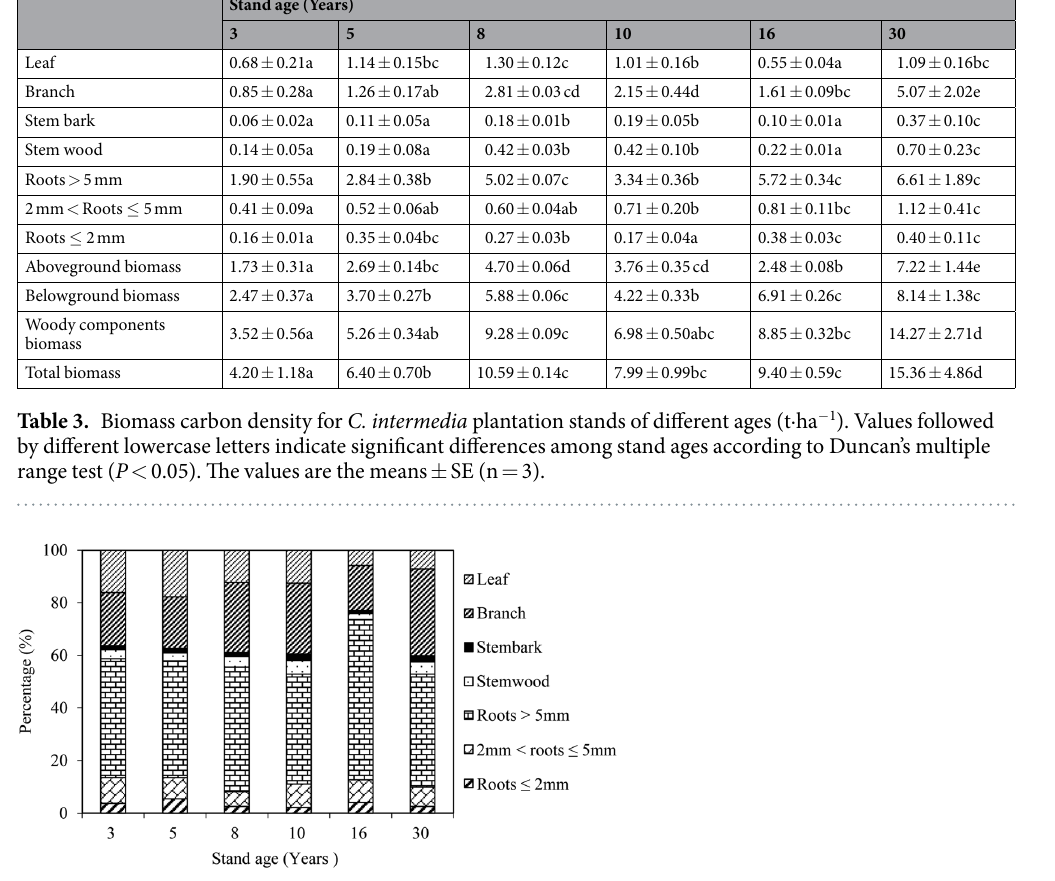
Figure 2. Proportion of the biomass carbon density of different components in the C. intermedia plantation stands of different ages